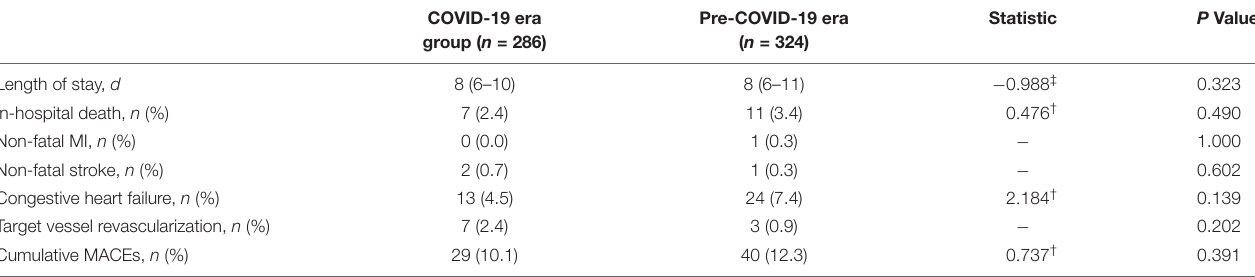
TABLE 3 | Clinical outcomes data.